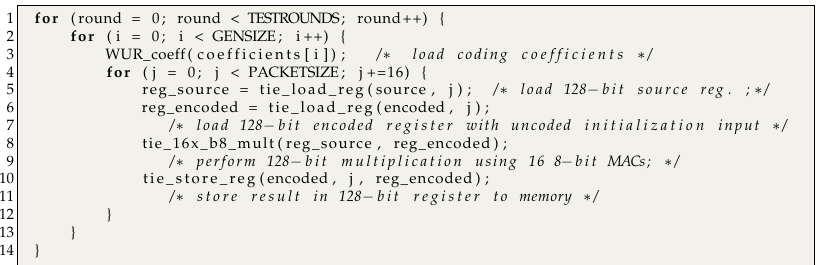
Figure 3. SIMD code: Illustration of the transformation of plain C code to a code with tensilica instruction-set extension (TIE) operations.